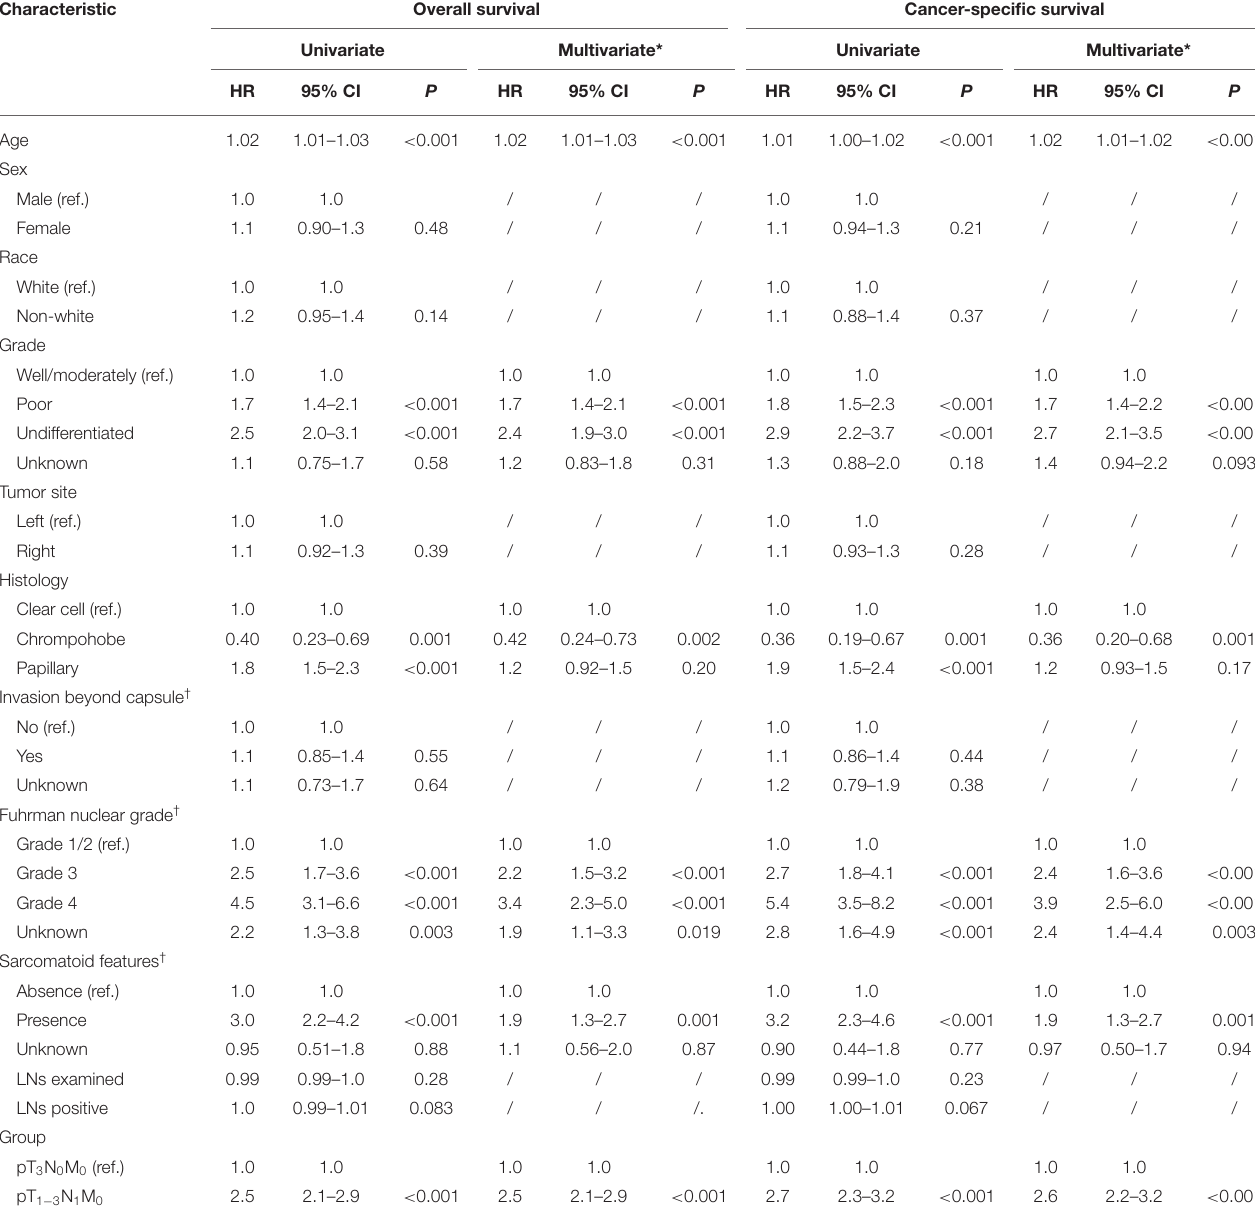
TABLE 3 | Univariate and multivariate analyses of overall survival and cause-specific survival to pT 3 N 0 M 0 and pT 1 − 3 N 1 M 0 groups before matching, SEER 2004-2015. Characteristic Overall survival Cancer-specific survival Univariate Multivariate* Univariate